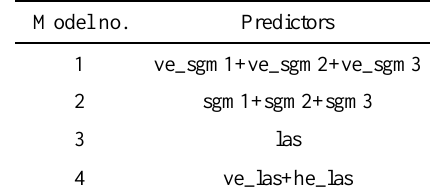
Table 3. The model numbers and predictor variables (explained in Table 2) in the selected